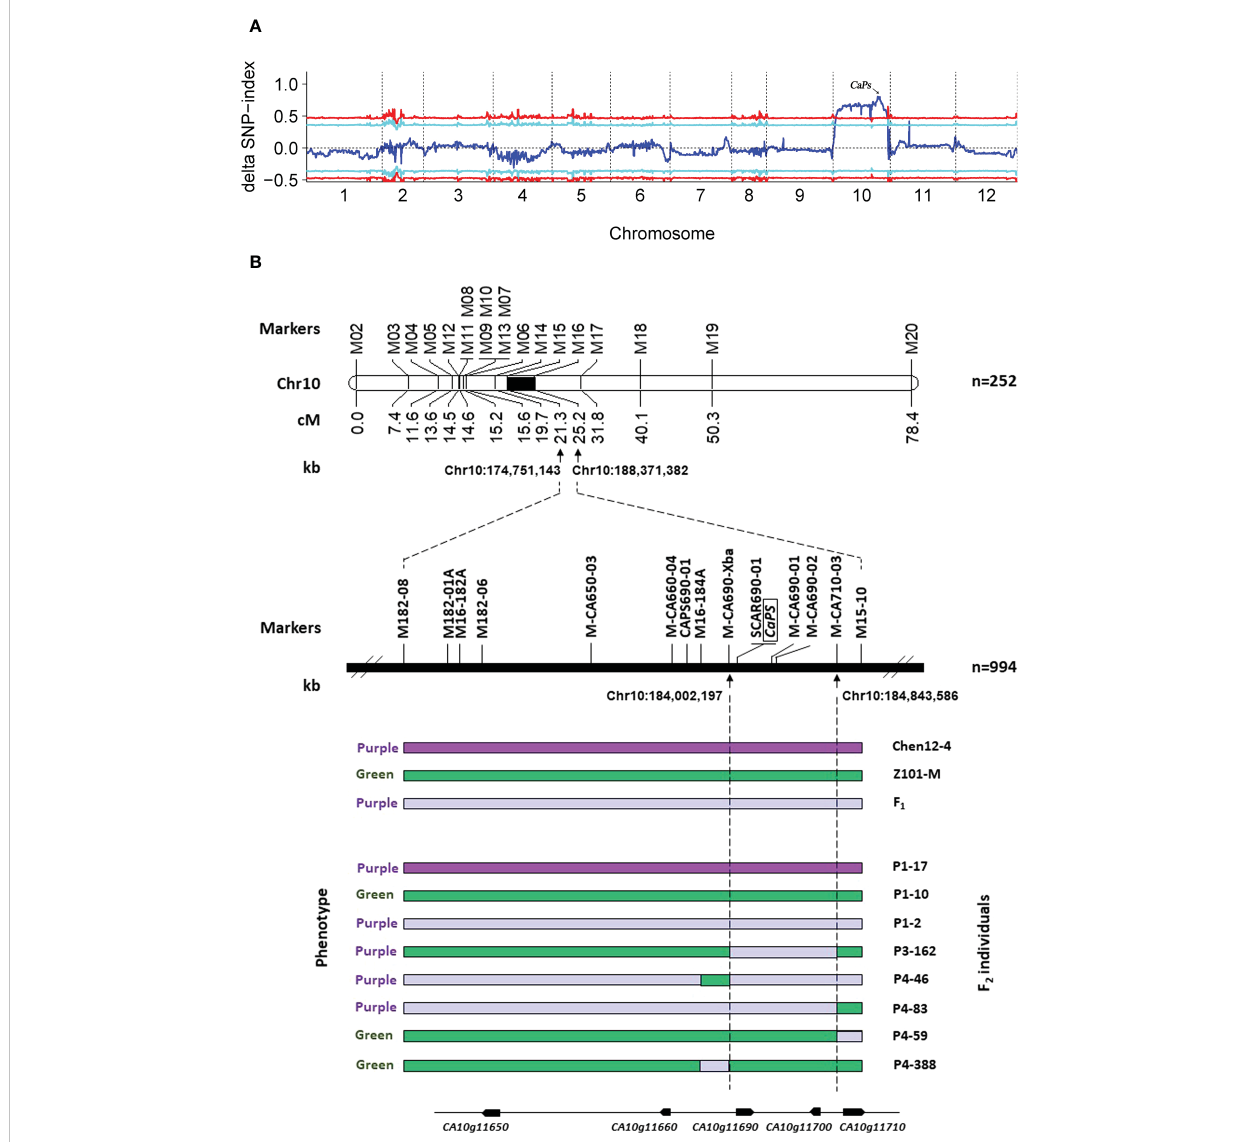
FIGURE 2 Genetic map, and identi fi cation of candidate CaPs locus in pepper. (A) Graphs of D SNP-index for SNP-index-based association analysis. The 12 chromosomes are represented along the x-axis, and the D SNP-index values are shown along the y-axis. (B) Genetic and physical maps of the CaPs gene and candidate gene analysis. CaPs was mapped to chromosome 10, between 184,002 kb and 186,844 kb in CM334 genome version 1.55. The genotypes of F 2 plants homozygous for the green or purple CaPs allele or heterozygous are shown as green, dark purple, and light purple bars, respectively. Eight bars at the bottom represent the genotypes of informative individuals with recombination